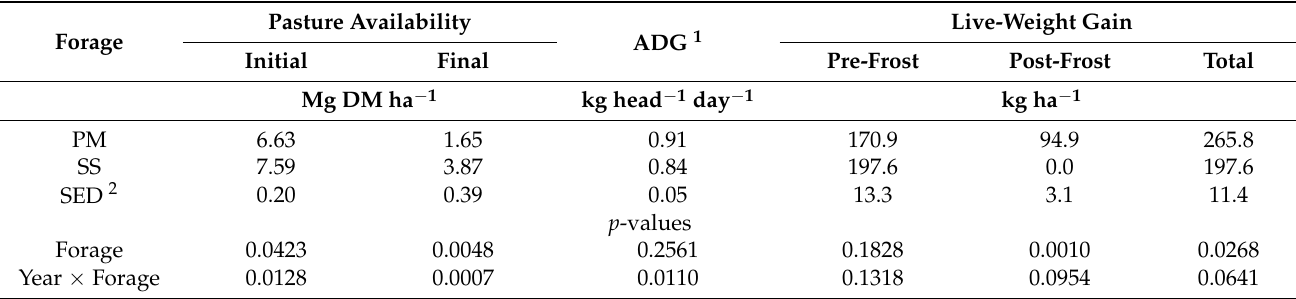
Table 3. Pasture dry matter (DM) availability and animal weight gain of growing beef cattle grazing pearl millet (PM) and sorghum–sudangrass (SS) pastures during the frost-prone autumn at Tucumcari, NM USA, in 2013 and 2014. Data are the least squares means of two replicates and two